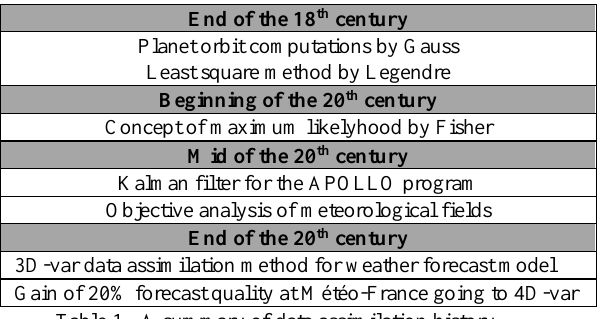
Table 1. A summary of data assimilation history (cid:1) (cid:1)